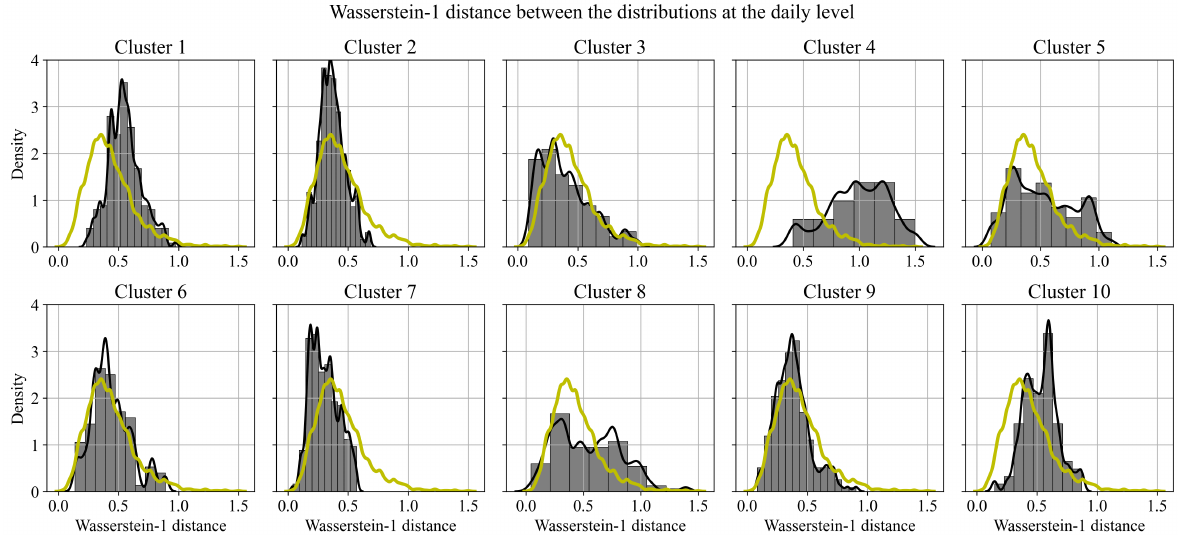
Figure 12. Histograms of the Wasserstein-1 distance between the distributions of the consumption and peak demands probability functions at the daily level. The black plot denotes the density for the individual cluster, while the plot in yellow indicates the density of the full dataset.